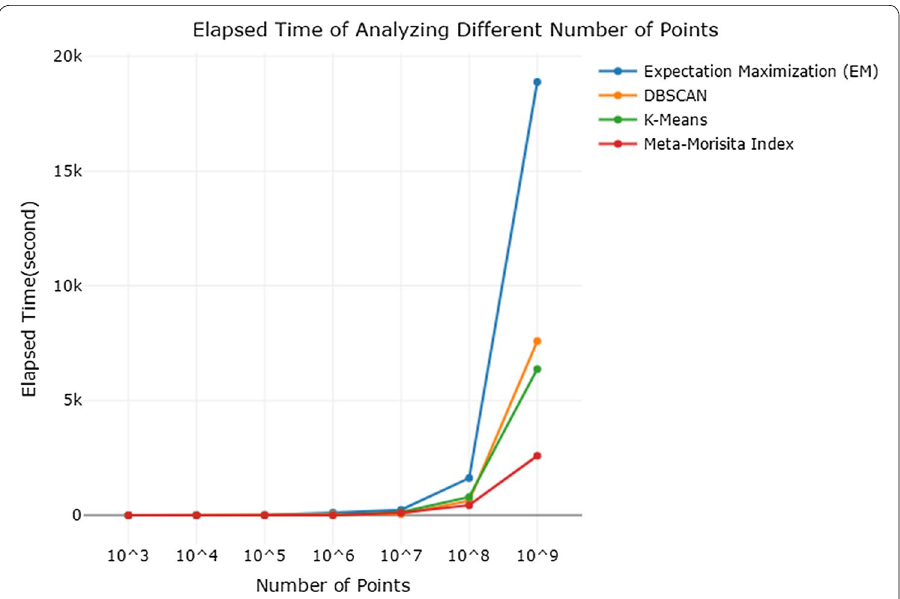
Fig. 19 Performance Comparison among meta-Morisita index, K-means clustering, density-based spatial clustering of applications with noise (DBSCAN) and expectation maximization (EM) Clustering